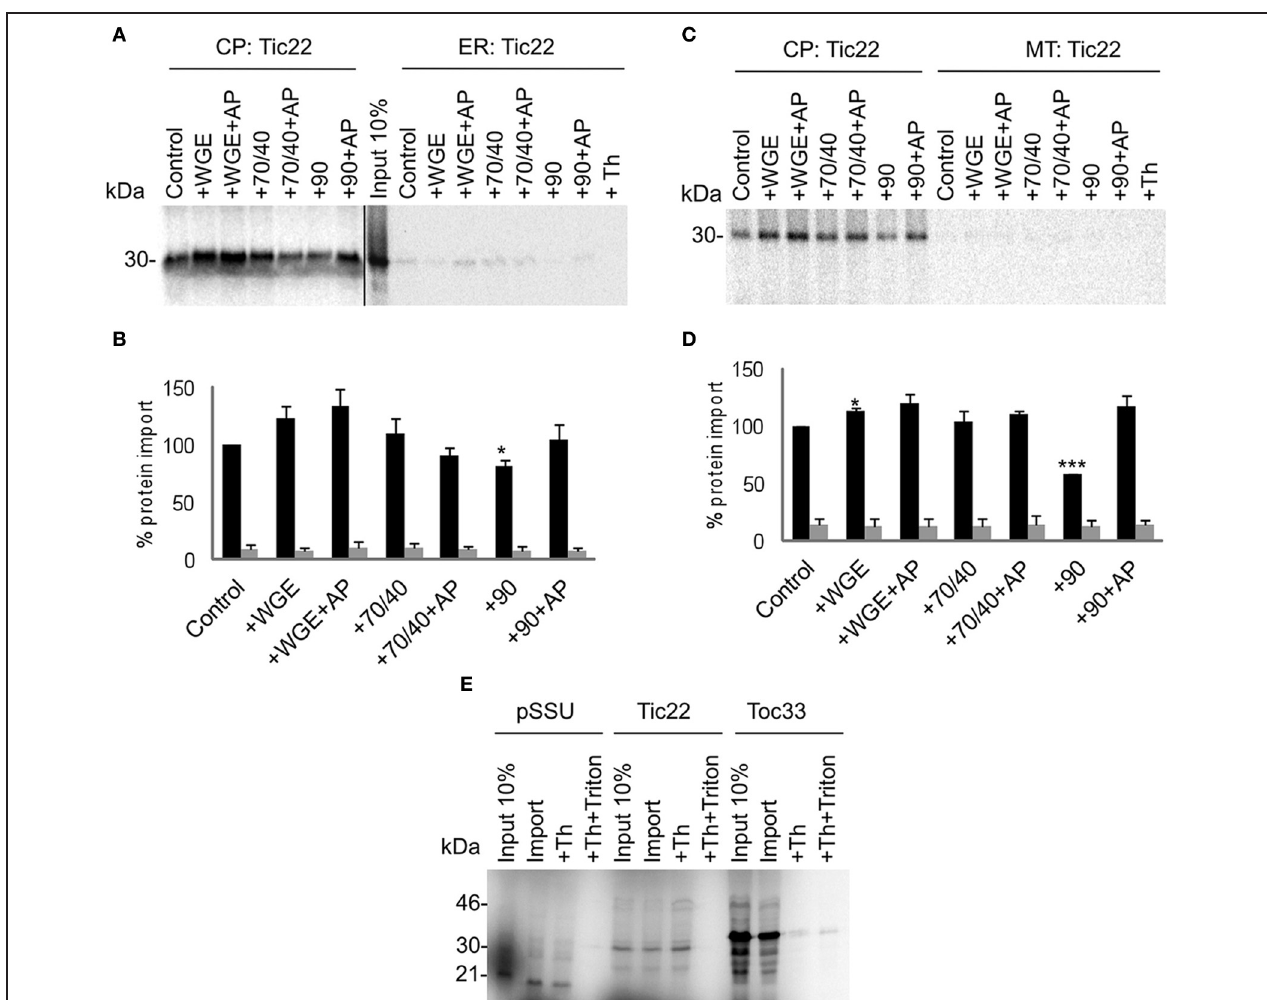
FIGURE 5 | Tic22 targets to chloroplasts efficiently and selectively under a wide range of cytosolic conditions. (A) Radio-labeled Tic22 protein derived from RNCs was incubated in a competitive targeting assay with chloroplasts (CP) and ER, with the addition of cytosolic components as indicated; control is buffer only, WGE is wheat germ extract, chaperones (Hsp) are indicated by their numbers (70/40 or 90), and AP represents apyrase treatment. Membranes were refractionated, treated with thermolysin where indicated (Th), and washed with carbonate for analysis by SDS-PAGE. 10% of protein input is shown, and the protein molecular weight markers are indicated in kDa. (B) Quantification of protein import in part A. Mean and standard error are shown, normalized to the control import into